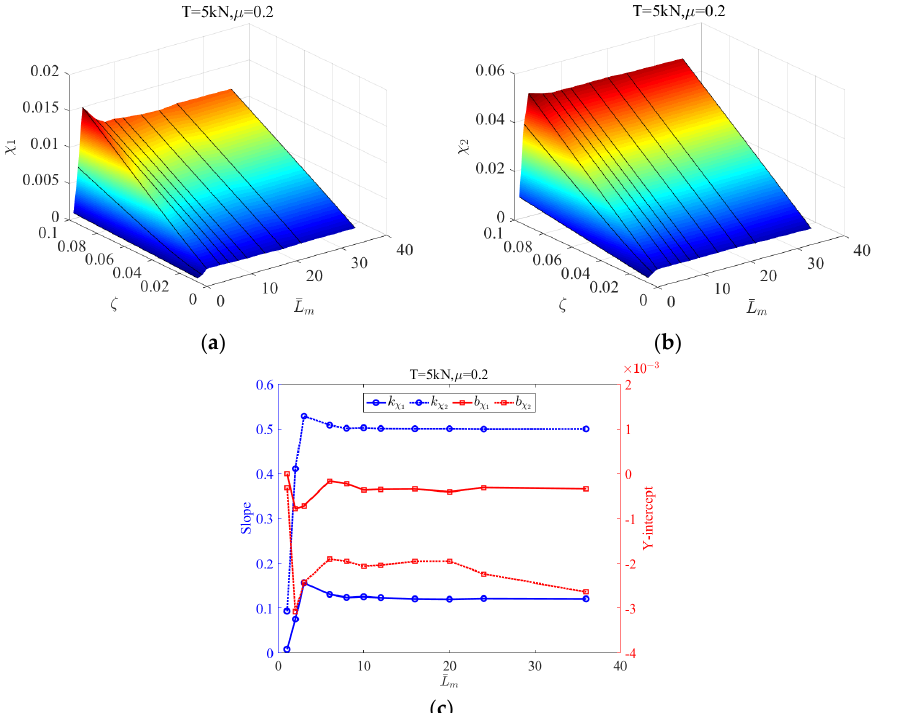
Figure 11. Three-dimensional plot of fitting coefficient of deflection curve for strands with different lengths: ( a ) χ 1 − L m − ζ and ( b ) χ 2 − L m − ζ ; ( c ) the slope and intercept of χ i − ζ line for each strand with friction coefficients 0.2 and 5 kN in tension.